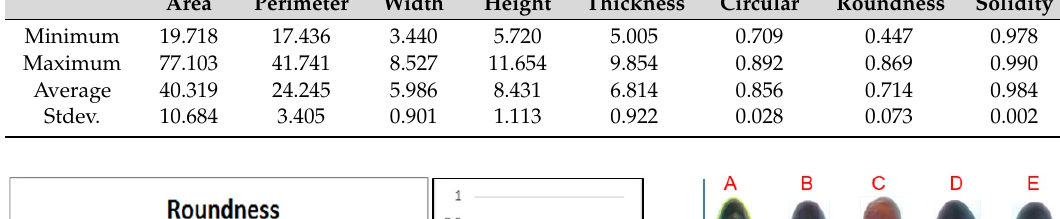
Table 2. Soybean 400 lines morphological range of measurements.